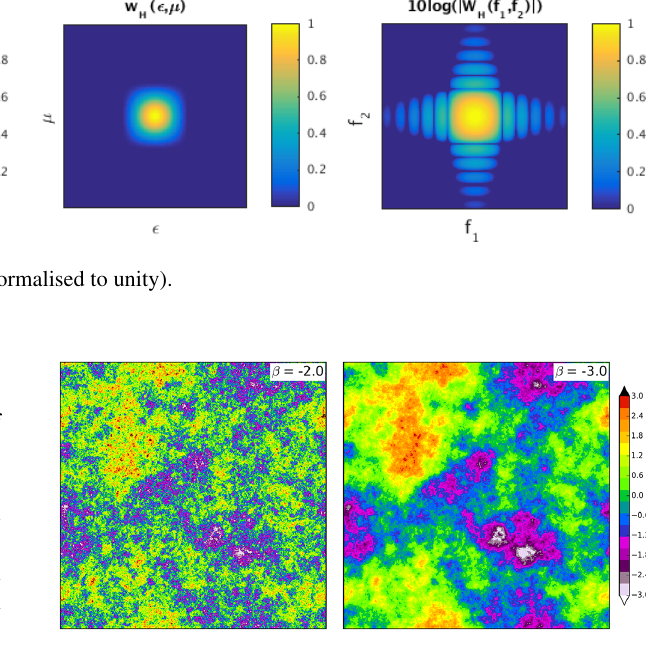
Figure 3. Examples of 512px × 512px synthetic fields of corre- lated noise produced with an isotropic power-law filtering of Gaus- sian white noise using two different values of β . Both noise fields have been drawn from the standard normal distribution and share the same random